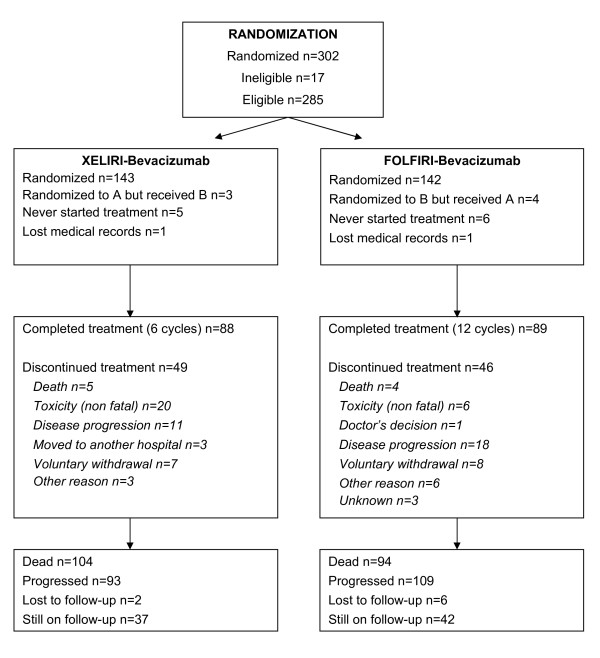
Consort diagram: Among 285 eligible patients 143 were randomized in group A (XELIRI-Bev) and 142 in group B (FOLFIRI-Bev). In group A 88 (61%) and in group B 89 (63%) of the patients completed treatment. Reasons of discontinuation were death, non-fatal toxicity, disease progression and doctor’s or patient’s decision. Discontinuation rates did not differ between the two groups (p = 0.80).